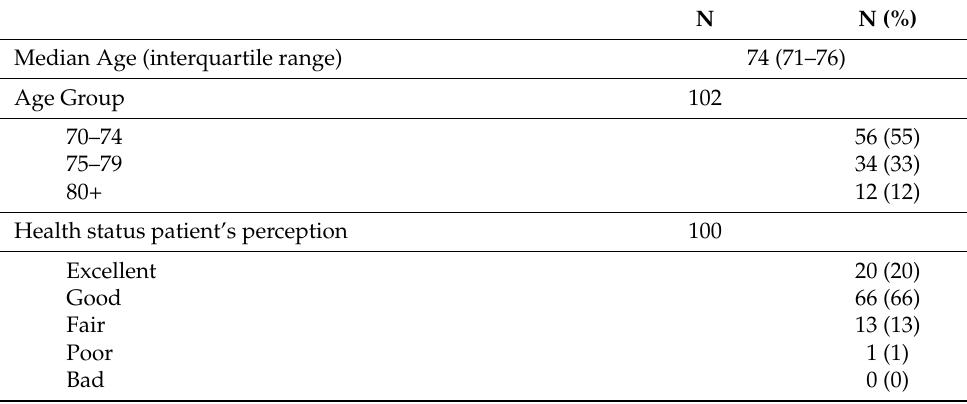
Table 1. Patient demographics, health conditions and medical